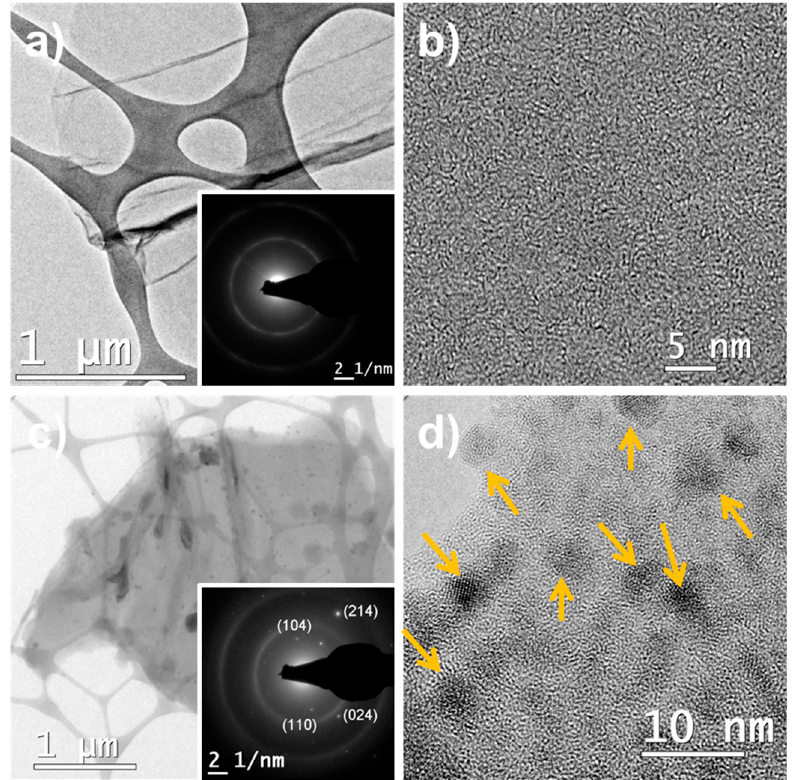
Figure 3. Transmission electron microscopy (TEM) analysis of ( a , b ) RGO as control and ( c , d ) α -Fe 2 O 3 /RGO hybrid material. Insets in ( a ) and ( c ) show the selected-area electron diffraction (SAED) analysis for the respective materials.